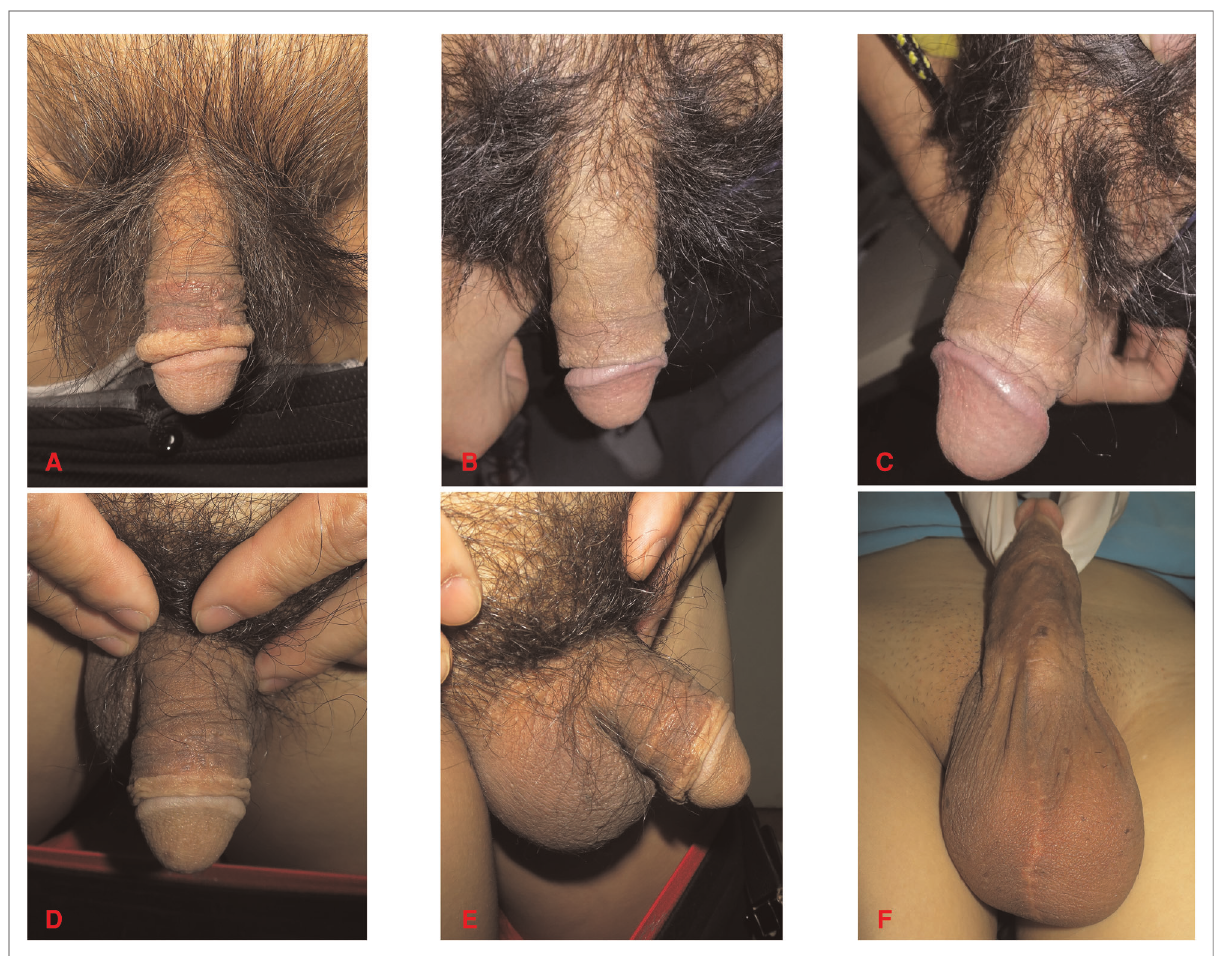
FIGURE 4 Same patient as in Figure 1 . ( A ) Three months after surgery. ( B,C ) Six months after surgery. ( D ) Photograph of the dorsal side of the penis 12 months after surgery. ( E ) Photograph of the lateral side of the penis 12 months after surgery. ( F ) Healing status of the donor site 12 months after the